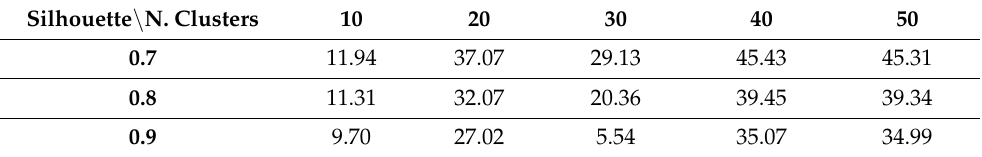
Table 43. Clustering performance in terms of silhouettes using original data. Silhouette \ N. Clusters